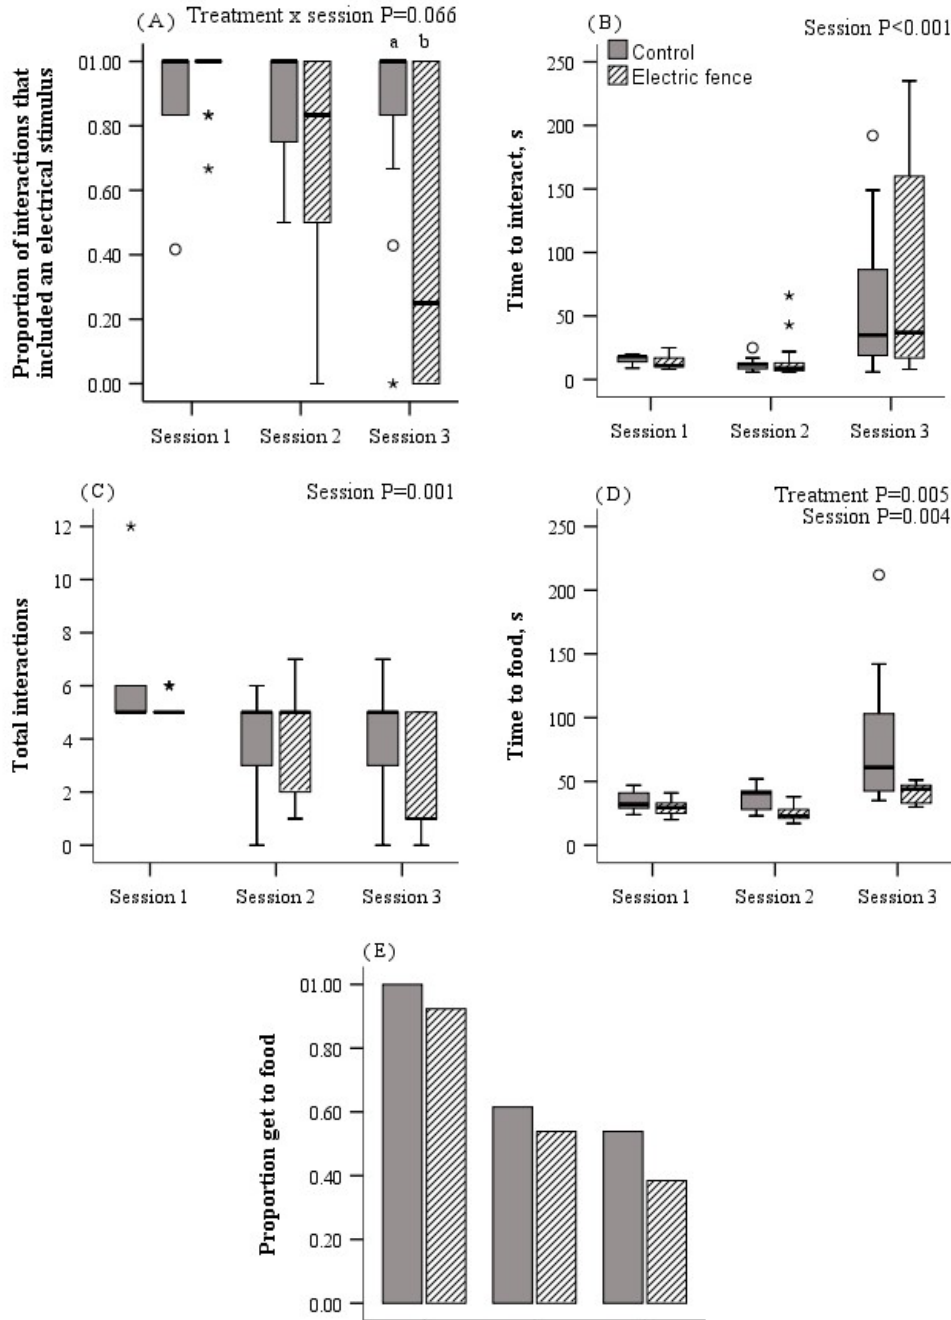
Figure 6. Using data from the first three training sessions, for heifers that had experience of electric fencing (dashed) or no previous experience of electric fencing (control, grey) the ( A ) proportion of interactions with the virtual fence during which an electrical stimulus was delivered, ( B ) time to interact with the virtual fence, ( C ) total number of interactions with the virtual fence, ( D ) time to reach the feed attractant, and ( E ) the proportion of heifers to reach the feed attractant. Raw means are presented. Estimated marginal means are presented in Table S2. Boxplots (Figure 6A–D) show the median and the first and third quartiles (25 and 75% of data), with whiskers extending to the lowest and highest values. Values greater than 1.5 × the interquartile range (IQR) are indicated by and greater than 3 × the (cid:35) IQR are indicated by *. In the case of an interactive e ff ect, di ff erent superscript letters ab show where treatment means di ff